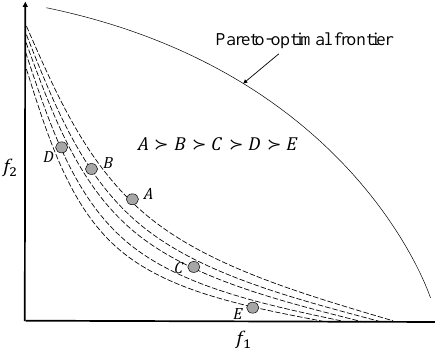
Figure 13. Value function fitting when the points are ordered.